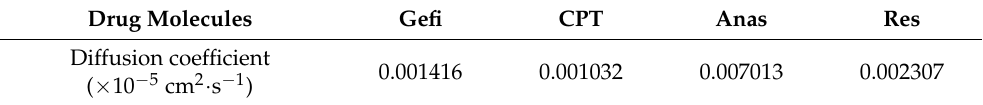
Table 2. Self-diffusion coefficients of different drugs adsorbed on graphene oxide surface. Drug Molecules Gefi CPT Anas